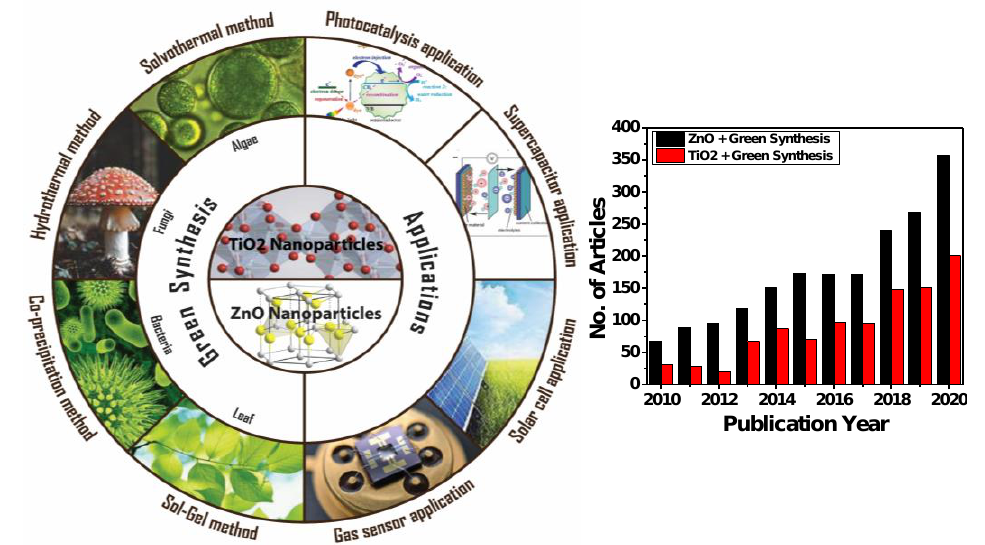
Figure 1. Schematic illustration of green synthesis approach of ZnO and TiO 2 nanoparticles (NPs) and their application. The number of publications on green synthesis of ZnO and TiO 2 NPs from 2010 to 2020 (internet search of Scopus on 10 March 2021). Keywords searched: ZnO + Green Synthesis and TiO 2 + Green Synthesis.